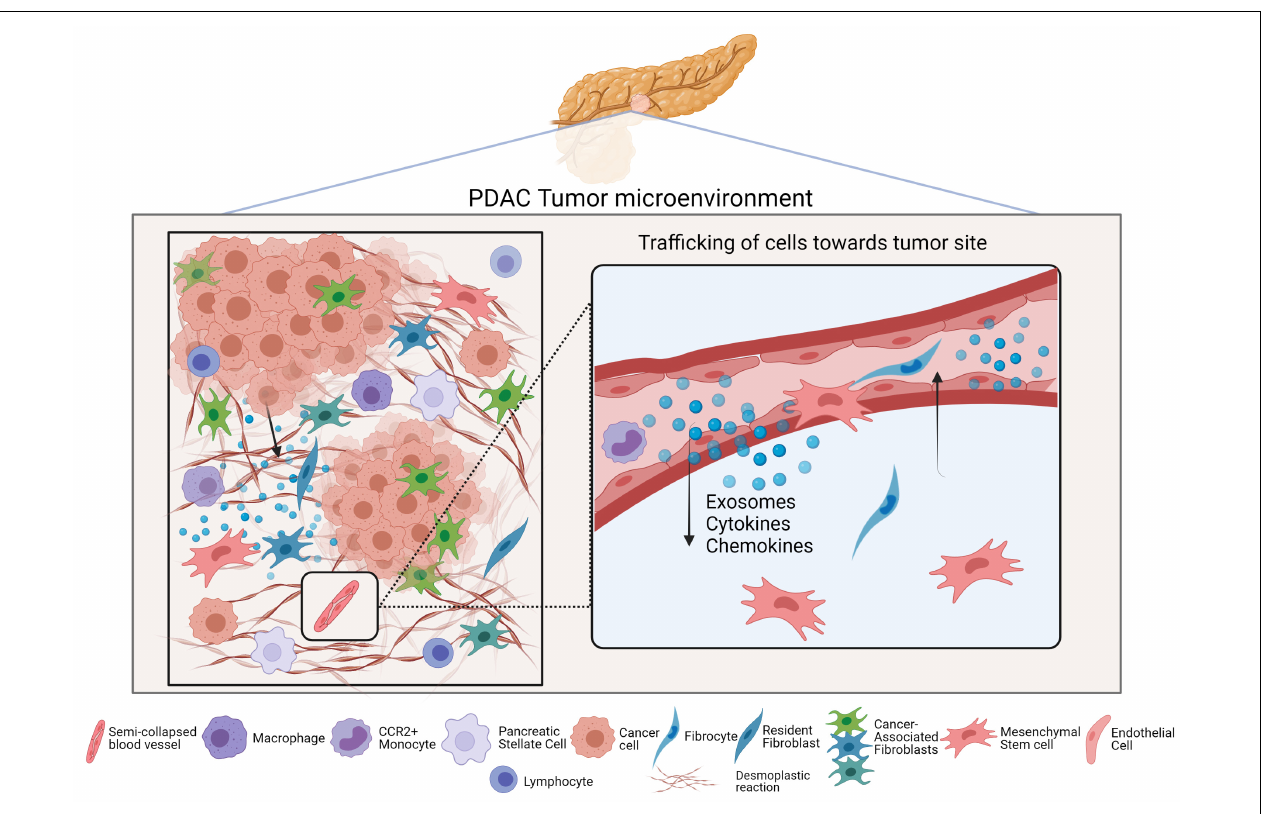
FIGURE 2 | Cell trafficking and the PDAC tumor microenvironment. The left panel of the figure is a simplified depiction of the PDAC tumor microenvironment and includes the major cell types that reside in it. The right panel is a magnified view of how different secreted factors serve to recruit CAF progenitors into PDAC tumors wherein they enrich the CAF